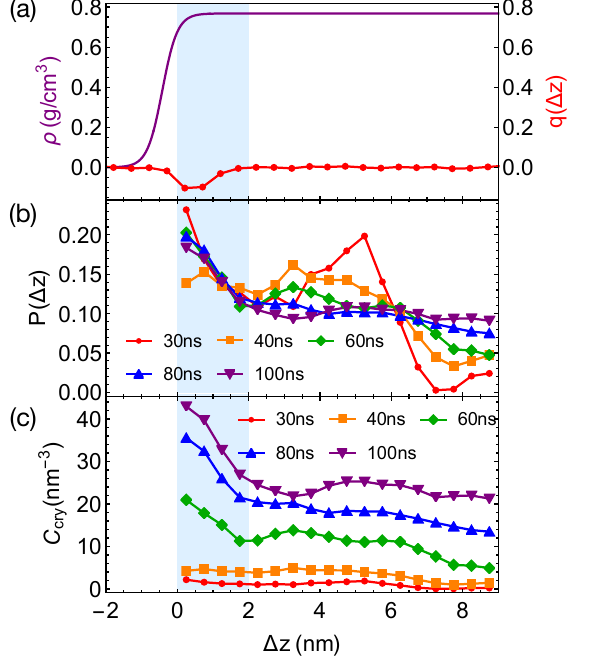
Figure 8. ( a ) Hyperbolic density profile of PE a by fitting data in Figure 4a and nematic order induced by interfaces; ( b ) probability distribution of crystalline atoms vs. distance ∆ z from the closest planar interfaces at different simulation time; ( c ) concentration of crystalline atoms vs. ∆ z at different simulation time. Data in ( b , c ) are averaged over eight trajectories. The blue region indicates the orientationally ordered layer in PE a